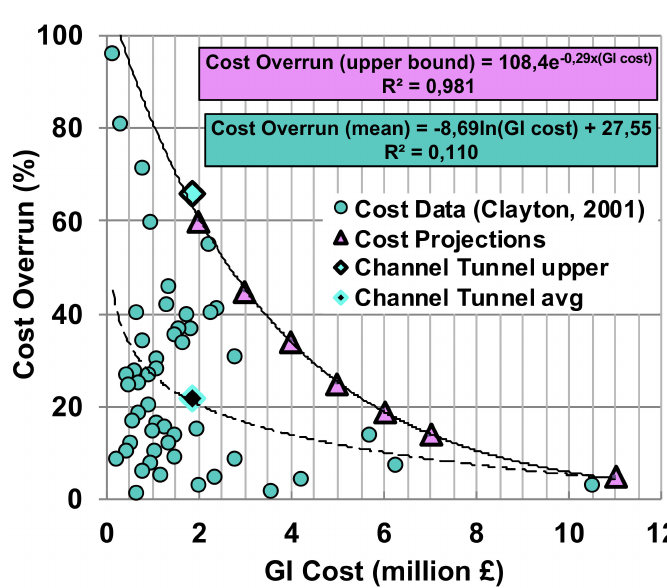
Figure 11. Tunnelling Cost (TuC) as a percentage of Construction Cost (CC) and Total Cost (ToC) for the tender in 1987 and the final phase—post construction in